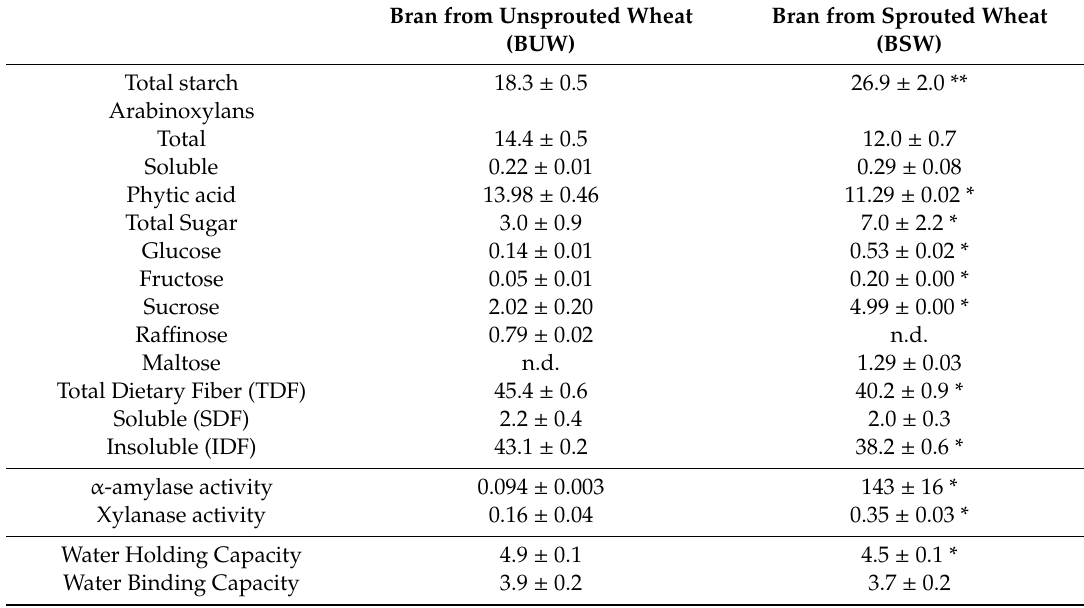
Table 1. E ff ect of sprouting on wheat bran